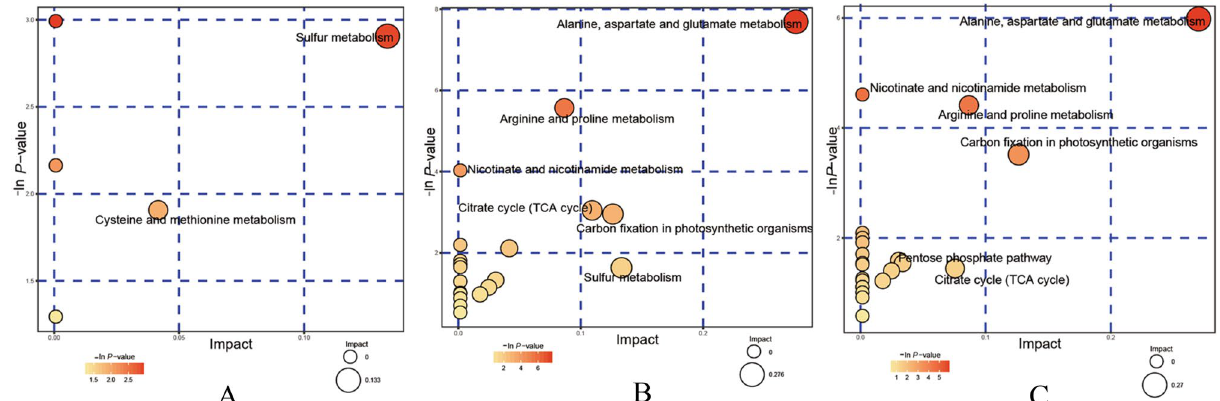
Figure 8. Pathway analysis of the leaves of N. sibirica in response to the different treaments. Each bubble in the bubble graph represents a metabolic pathway. The abscissa and size of the bubble represent the influencing factor of this pathway in the topological analysis; the larger the size is, the greater impact factor. The ordinate and color represent the P -value of the enrichment analysis (− ln[ P -value]); the deeper the color is, the smaller the P -value and the more significant the degree of enrichment. ( A ) T0L vs. T100L; ( B ) T0L vs. T400L; ( C ) T100L vs.